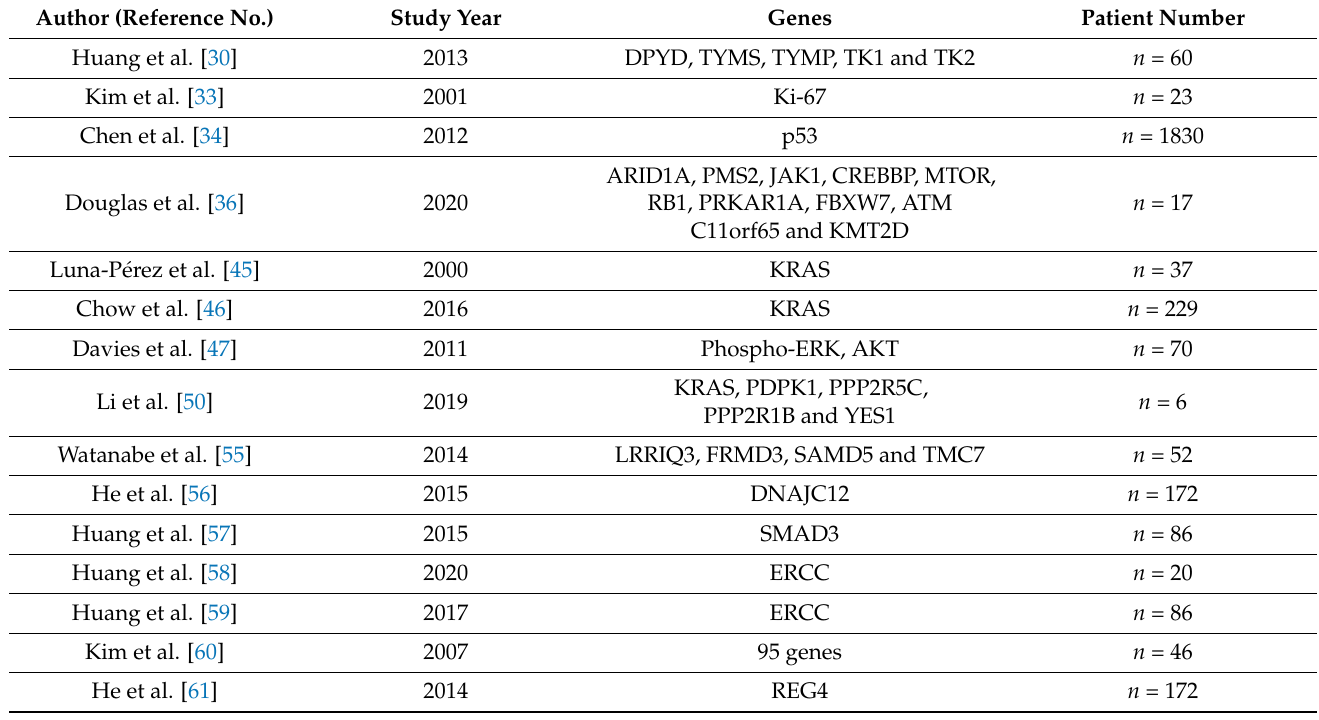
Table 2. Molecular genetic markers: Oncogenes and tumor suppressors regarding tumor response after neoadjuvant treatment for locally advanced rectal